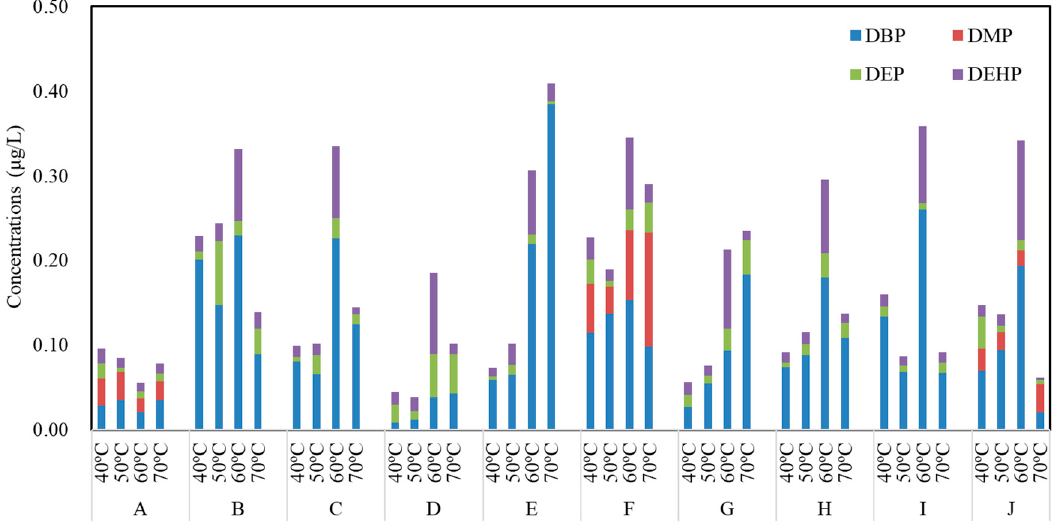
Figure 5. Total concentrations ( μ g/L) of PAEs in pure water stored in 10 brands of PET bottles after incubation at 40, 50, 60 and 70 °C for 24 h ( n = 3).